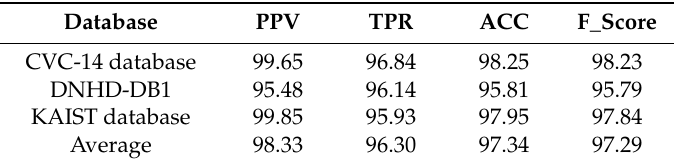
Table 7. Average testing accuracies of human and background detection with images processed by HE (unit: %).